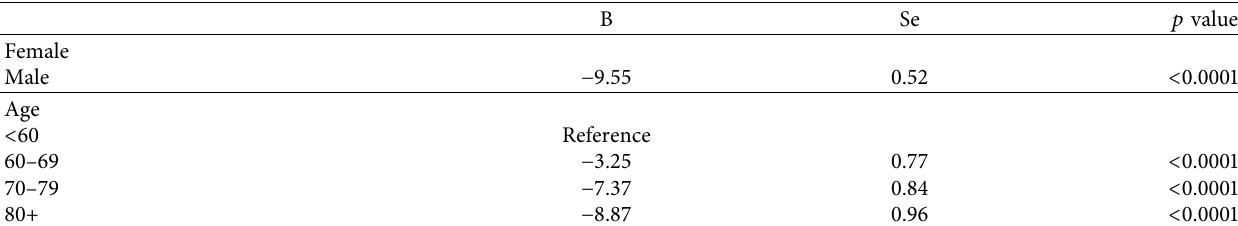
Table 2: Linear regression results for the last measured low-density lipoprotein cholesterol mg/dL level. N � 15,111 health system patients with documented coronary artery disease (CAD) ∗